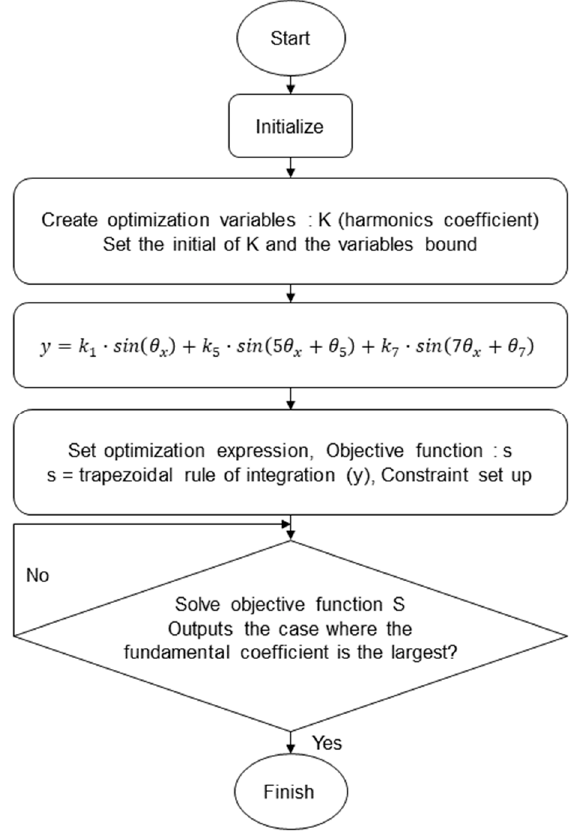
Figure 1. Process for optimizing harmonic coefficients.